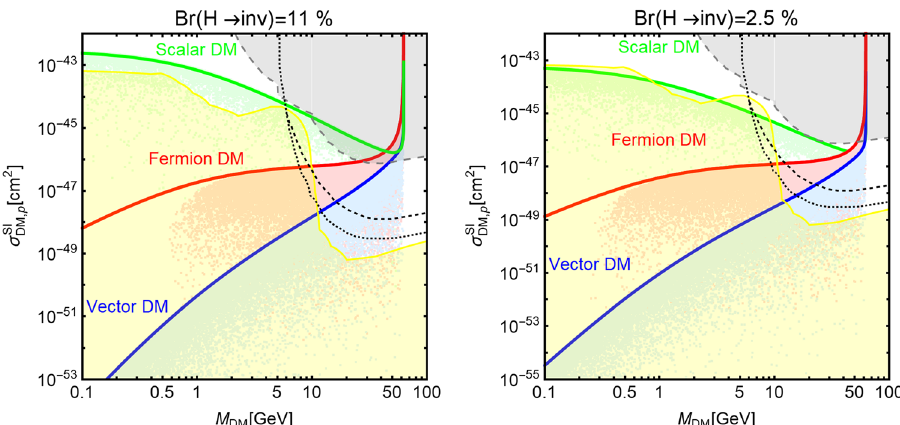
Fig. 3 Predictions for the DM scattering cross section in the scalar sponding renormalizable complete models with mixing of the SM-like Higgs field with an additional Higgs singlet, with the latter assumed to (green line), fermionic (red line), and vector (blue line) effective Higgs- be heavier than 125GeV. The gray areas show the regions excluded by portal scenarios, as functions of the DM mass, requiring a value of the XENON1T, while the additional lines illustrate the sensitivities asso- invisible branching fraction of the SM-like Higgs boson to be 11% (left ciated to XENONnT and DARWIN; the region corresponding to the plot) and 2 . 5% (right plot). The green, red and blue points represent so-called neutrino floor is shown in the value of σ SI obtained by varying the parameters of the corre- DMp